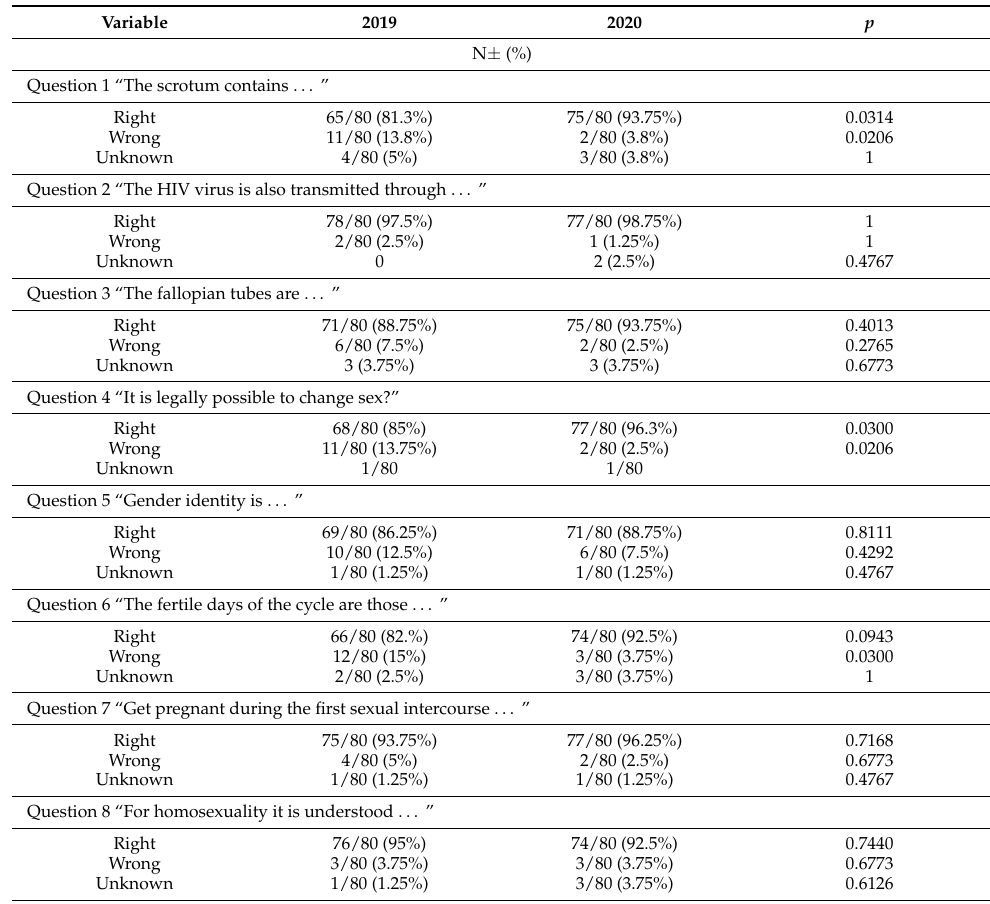
Table 2. Comparison between surveys one year later: